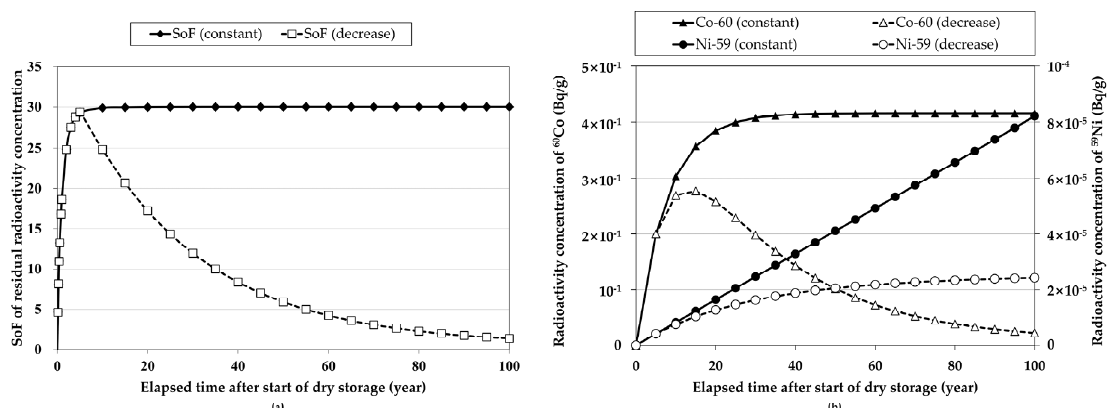
Figure 11. Residual radioactivity in the basket of the MPC-24, along with dry storage time of SNF with constant or time-dependent neutron source terms: ( a ) SoF of residual radioactivity, and ( b ) residual radioactivity concentrations of 60 Co and 63 Ni.